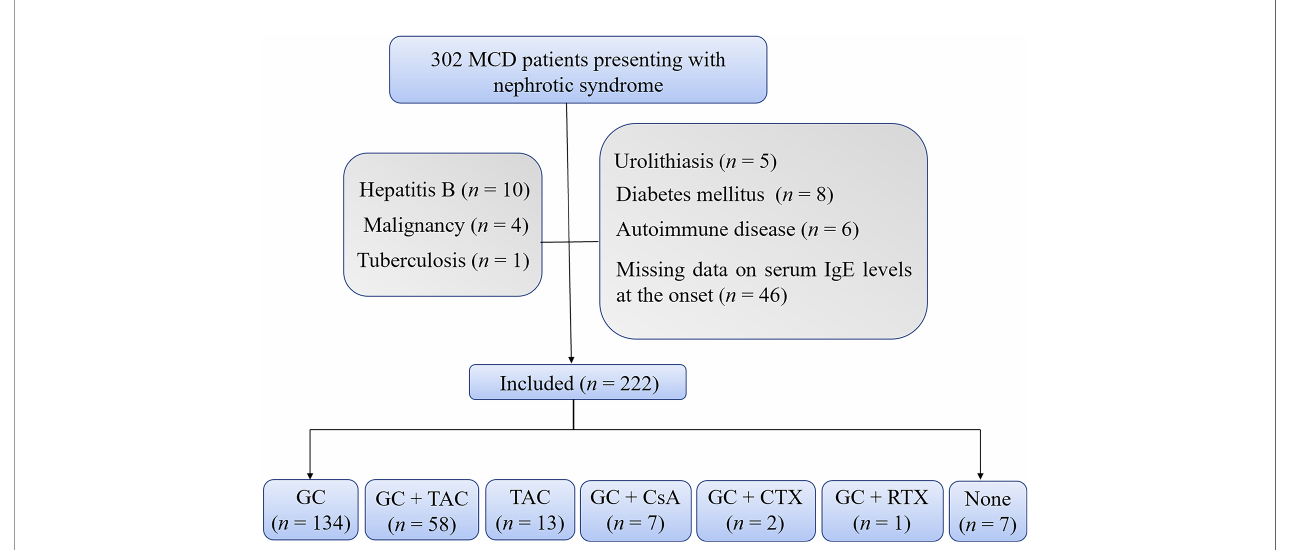
FIGURE 1 | Flowchart. The fl owchart shows 222 enrolled patients with 134 patients treated with glucocorticoids alone and 88 patients treated with other treatment regimens. CsA, cyclosporine; CTX, cyclophosphamide; GC, glucocorticoids; TAC, tacrolimus; RTX,